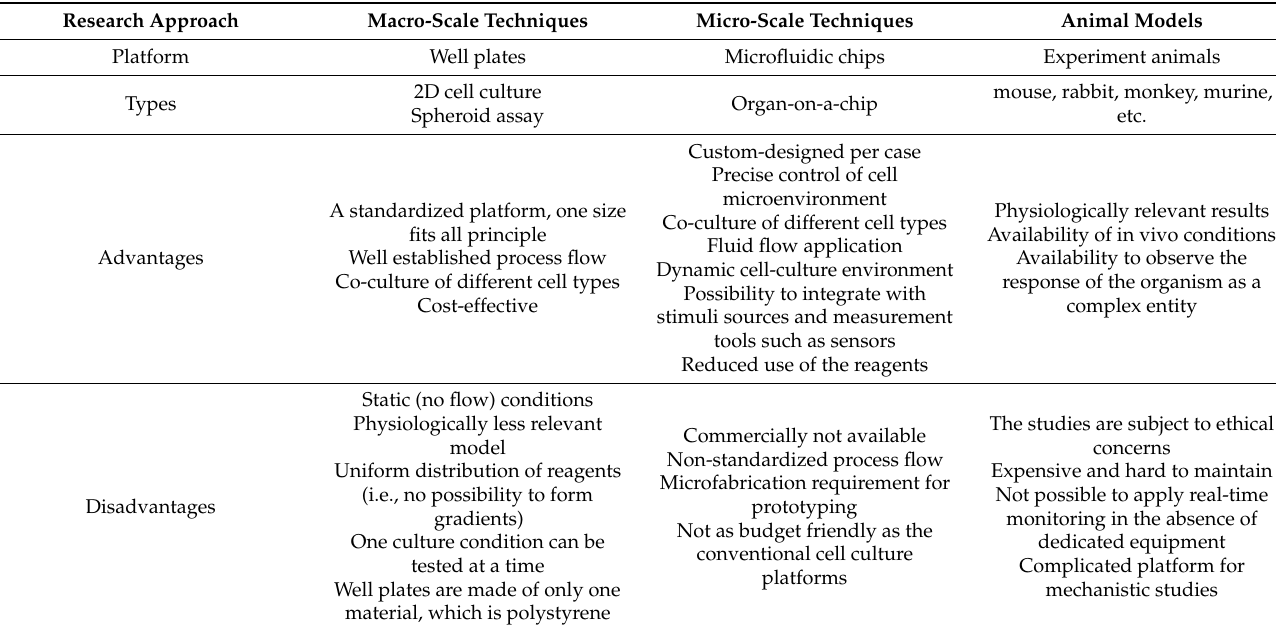
Table 1. Comparison between advantages and disadvantages of the available translational research